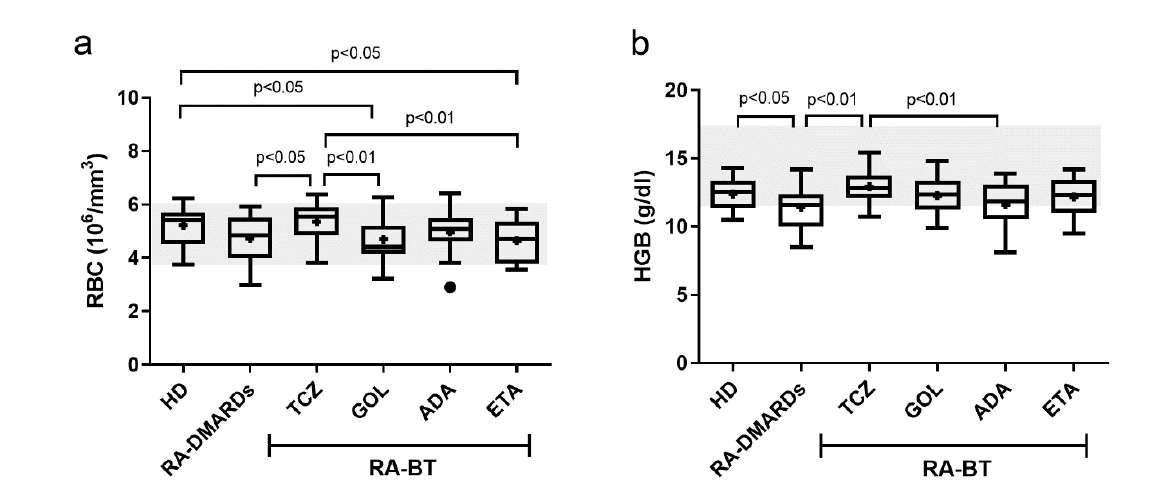
Figure 2: The number of red blood cells and hemoglobin levels in healthy donors (control), and RA patients undergoing a standard RA therapy (RA-DMARDs) or different types of biological treatment (RA-BT). The numbers of red blood cells (RBC; a ) and hemoglobin levels ( b ) were compared for healthy donors (HD, n = 20), patients with RA without BT (RA-DMARDs; n = 20), and RA patients receiving distinct BT (RA-BT) - tocilizumab (TCZ, n = 20); golimumab (GOL, n = 20); adalimumab (ADA, n = 20); or etanercept (ETA, n = 19). Data are presented as box plots displaying the median, mean (+), 25 th and 75 th percentiles, minimum and maximum (whiskers), and outliers’ values (●). The statistical difference was determined by unpaired two-tailed Student's t-test. The difference with p<0.05 was con- sidered significant. The grey area indicates a normal reference range for healthy